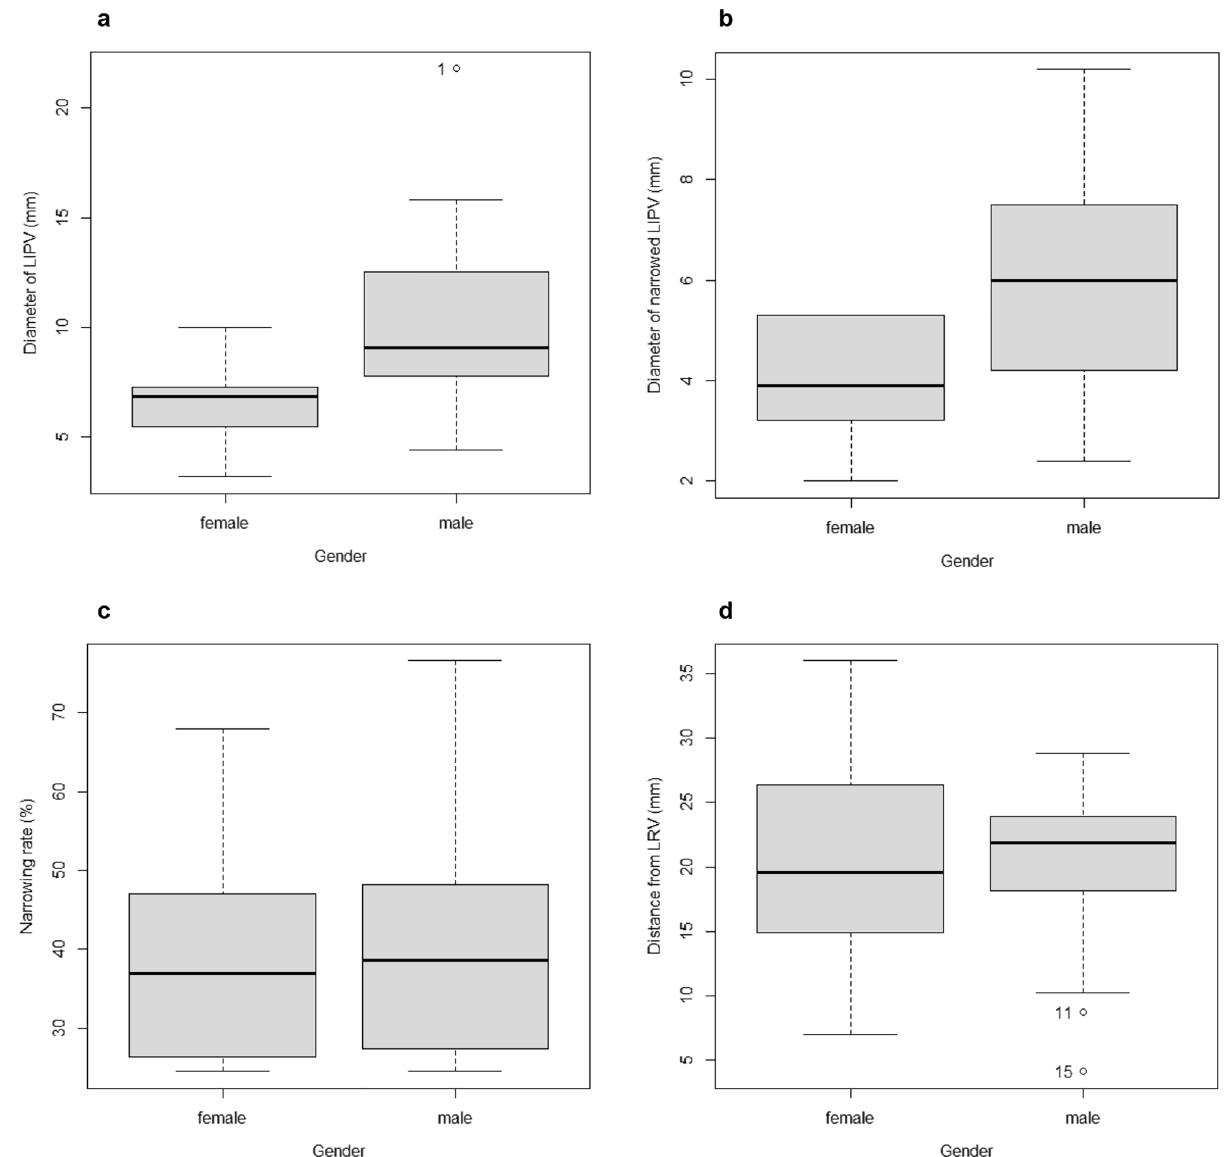
Figure 3. ( a ) Box plot of the diameter of LIPV in relation to sex ( p = 0.0056). ( b ) Box plot of the diameter of narrowed LIPV in relation to sex ( p = 0.013). c Box plot of the narrowing rate in relation to sex ( p = 0.55). d Box plot of the distance from LRV in relation to sex ( p = 0.83). The diameter of LIPV and the diameter of narrowed LIPV were significantly larger in males than in females, whereas no significant differences were observed in the narrowing rate or distance to narrowing from the left renal in the diameter of LIPV between males and females ( p = 0.0056 ) . with a 95% confidence interval of − 6.75 to − 1.32 mm (Fig. 3a). The diameter of narrowed LIPV ranged between 2.0 and 10.2 mm (2.4–10.2 for males and 2.0–5.3 for females), with a mean of 5.1 mm (5.9 for males and 3.9 for females) and standard deviation of 2.3 mm (2.5 for males and 1.2 for females). A significant difference was observed in the diameter of narrowed LIPV between males and females ( p = 0.013 ) . with a 95% confidence interval of − 3.56 to − 0.48 mm (Fig. 3b). The narrowing rate ranged between 24.5 and 76.6% (24.6–76.6 for males and 24.5–67.9 for females), with a mean of 40.6% (41.7 for males and 38.9 for females) and standard deviation of 16.0% (17.3 for males and 14.5 for females). A significant difference was not observed in the narrowing rate between males and females ( p = 0.55 ) (Fig. 3c). The distance to narrowing from the left renal vein ranged between 4.1 and 36.0 mm (4.1–28.8 for males and 7.0–36.0 for females), with a mean of 20.0 mm (19.8 for males and 20.3 for females) and standard deviation of 7.4 mm (7.2 for males and 8.2 for females). A significant difference was not observed in the distance to narrowing between males and females ( p = 0.83 ) (Fig. 3d).